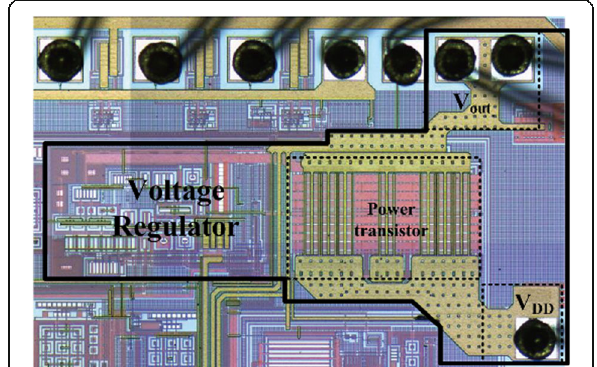
Fig. 7 PSR analysis of the proposed VR